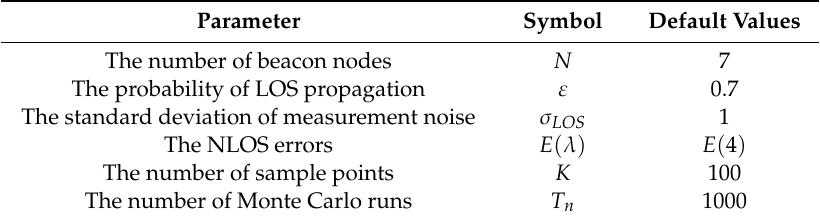
Table 2. The default parameters of an exponential